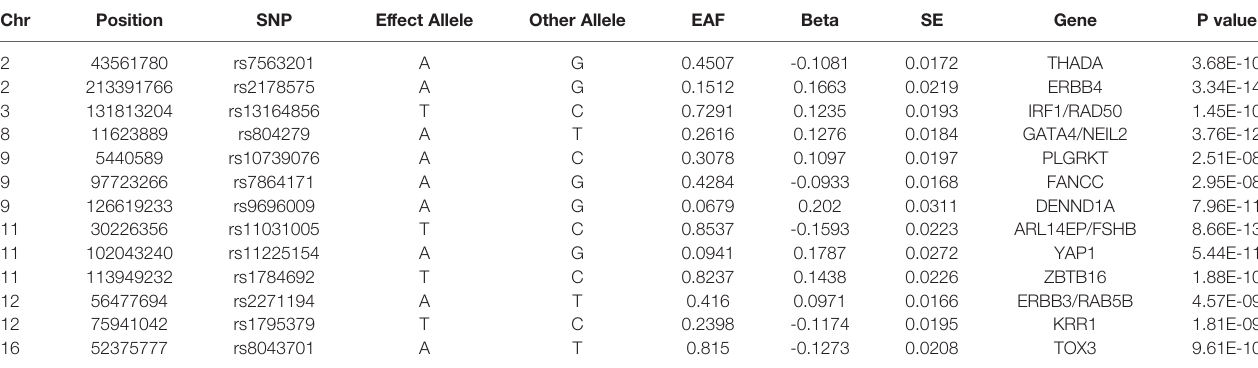
TABLE 1 | PCOS SNPs used to construct the instrument variable in Europeans.